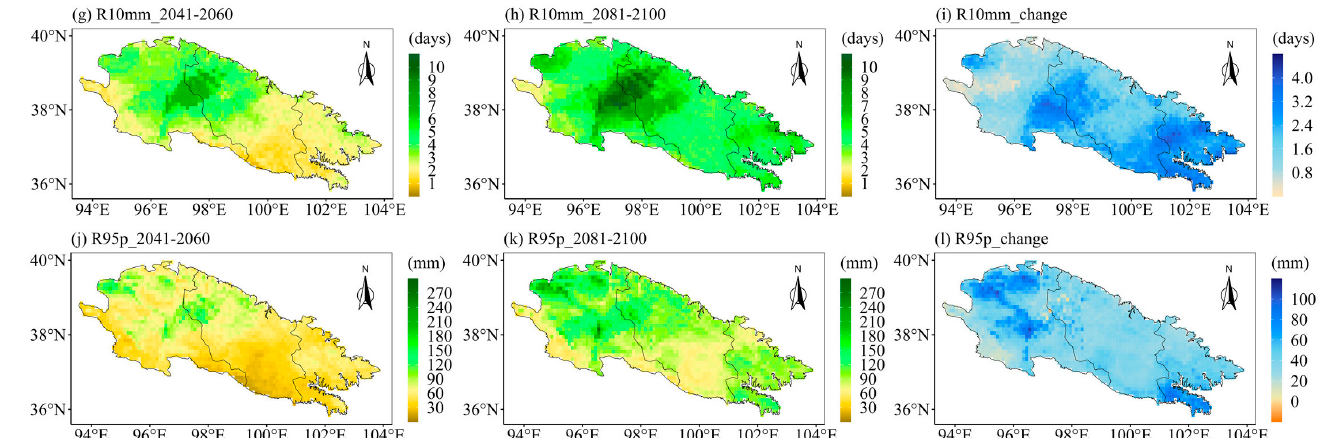
Figure 12. ( left ) The changes of extreme precipitation indices in the middle of the 21st century as compared to the base period, ( middle ) the changes of extreme precipitation indices at the end of the 21st century as compared to the base period, and ( right ) the changes of extreme precipitation indices at the end of the 21st century as compared to the middle of the 21st century. Spatial distribution over the Qilian Mountains under SSP585: ( a – c ) CDD, ( d – f ) CWD, ( g – i ) R10mm, and ( j – l ) R95p. Note that the future change is represented by the ensemble of the corrected CMIP6 models.